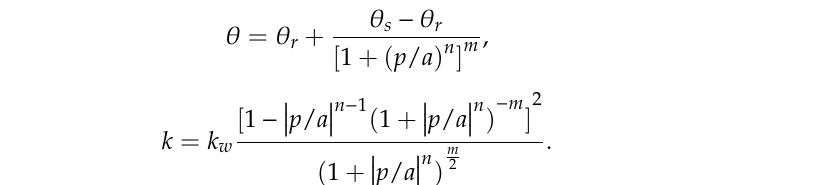
Figure 5. Initial pore pressure distribution.